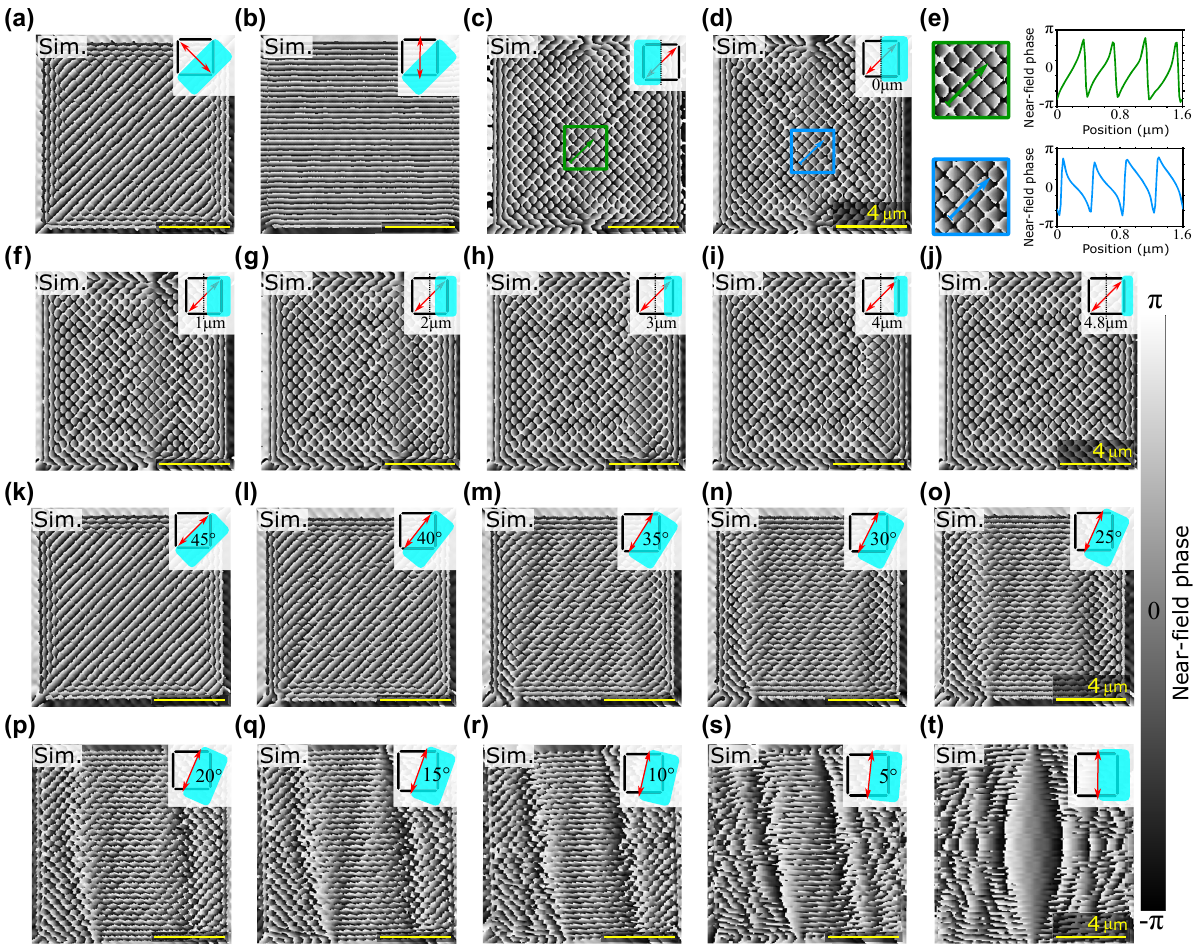
Figure 3: Numerical calculations of near-field phase distribution on square SPID. FDTD simulations of phase formed on a square SPID for different OBJ-REF divisions and polarizations. (a)–(d) High-symmetry examples. (e) Details from (c) and (d) with linear phase profiles. (f)–(j) Narrowing the REF wave region. (k)–(t) Rotating both the polarization and REF wave region in five-degree steps. Insets represent square arrangements of slits with the turquoise patch representing the REF wave area and the red double-sided arrow representing the illumination